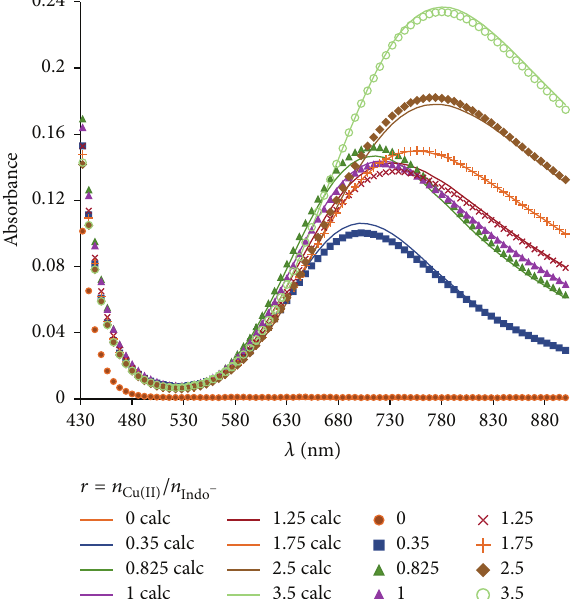
Figure 13: Comparison of the experimental spectra (markers) and thosecalculated(calc)fromtheformationconstantsrefinedwiththe